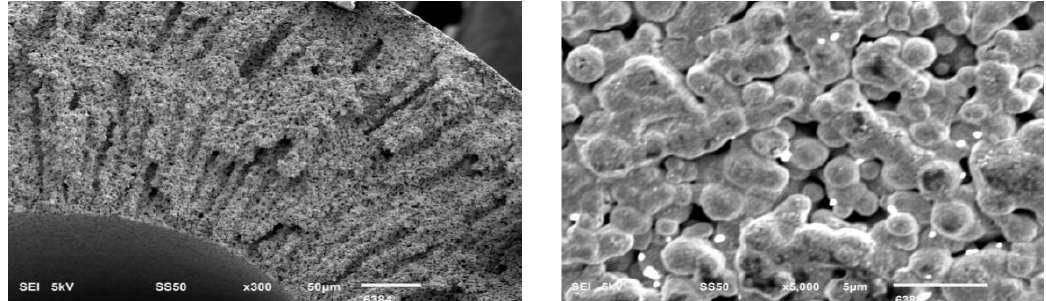
Figure A5. SEM images of the cross-section of the wall ( left ) and detail of the surface-structure ( Right ) of copper oxide hollow fibers after reduction at 200 °C for 1 h. The sample was treated in air for as long as 3 h, which is the optimized time as indicated in Figure A7.